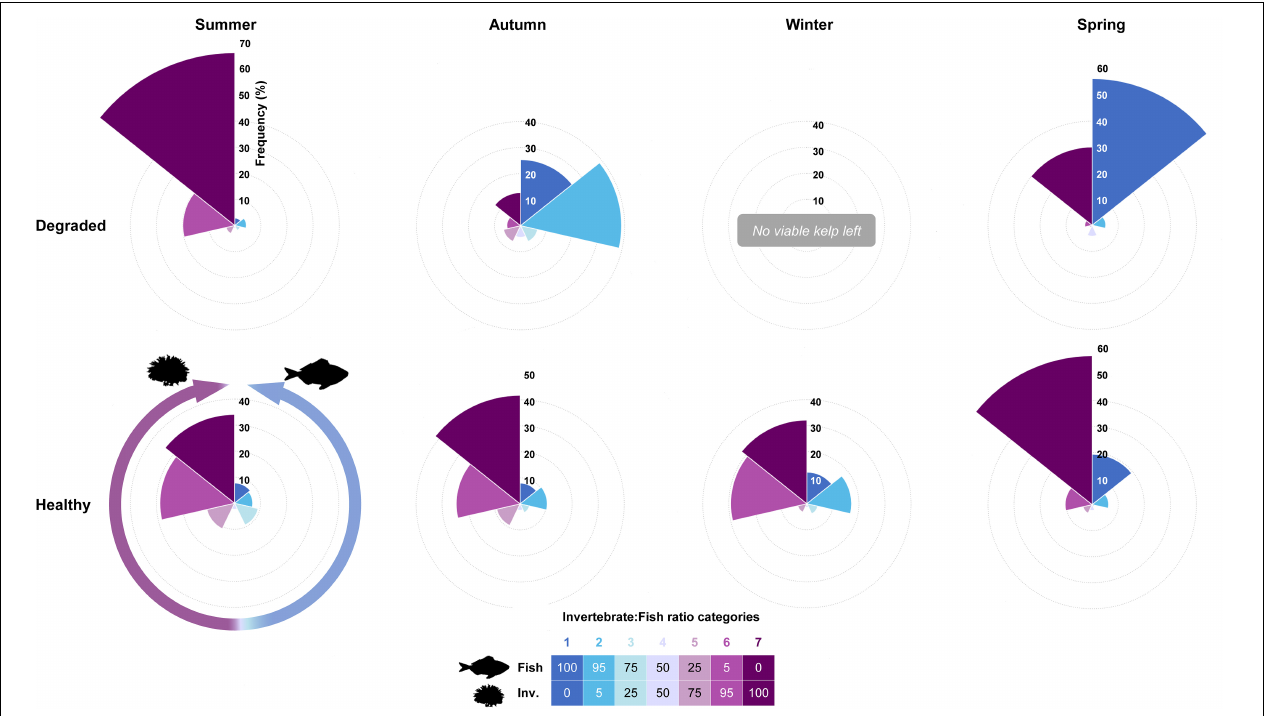
FIGURE 6 | Laminaria ochroleuca. Seasonal changes in the relative herbivory pressure by fishes and invertebrates. Frequency of Invertebrate/Vertebrate Ratio (IVR) categories recorded in kelps from HPI categories 1–4 sampled on degraded ( n = 729) and healthy ( n = 654) reefs (see text and Figure 5 for a detailed explanation of HPI categories). IVR is based on the relative length of herbivory marks by fishes and invertebrates found along the blade edge, assigning each kelp to one out of seven categories of Invertebrate: Fish ratios: IVR-1 (0:100 ratio, dark blue), IVR-2 (5:95), IVR-3 (25:75), IVR-4 (50:50), IVR-5 (75:25), IVR-6 (95:5), and IVR-7 (100:0, dark